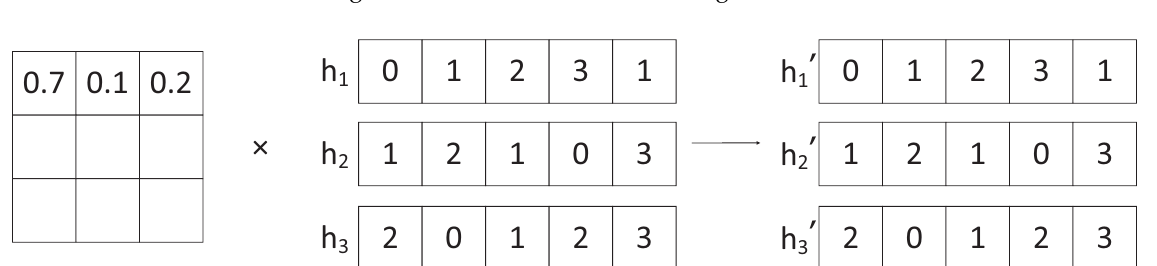
Figure 6. Normalization. 3.